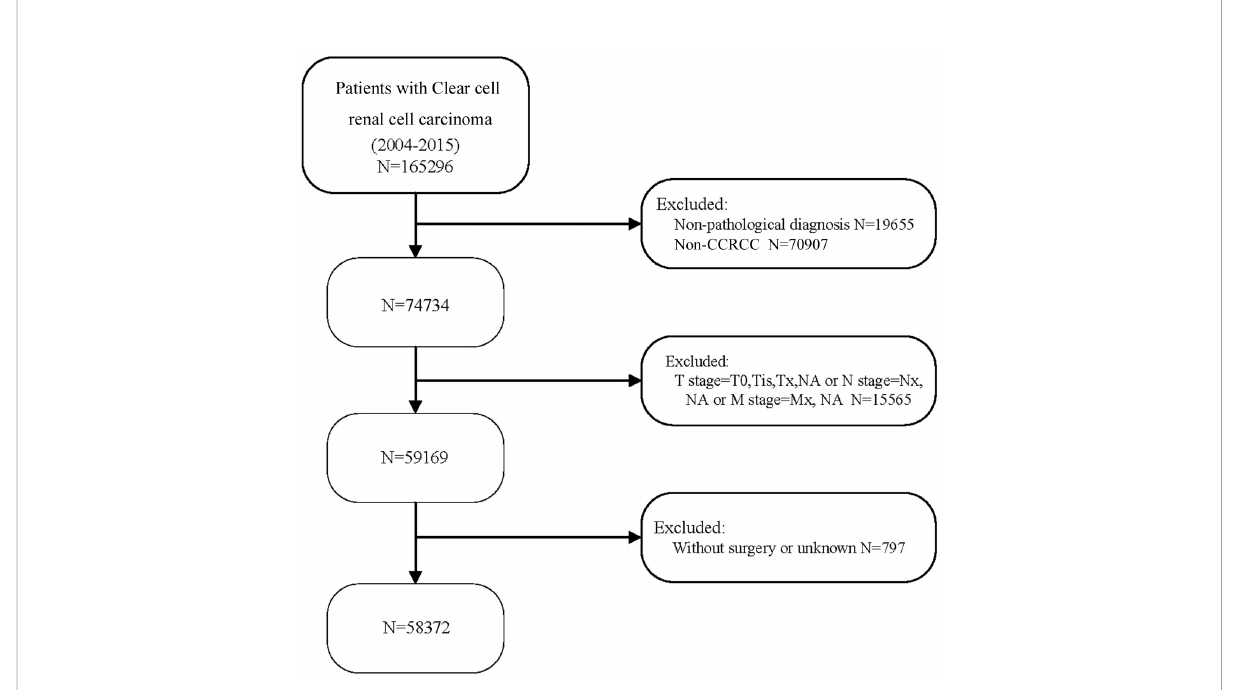
FIGURE 1 Flow chart for selecting patients with CCRCC. 2004-2015 CCRCC patients were selected in detail from the SEER